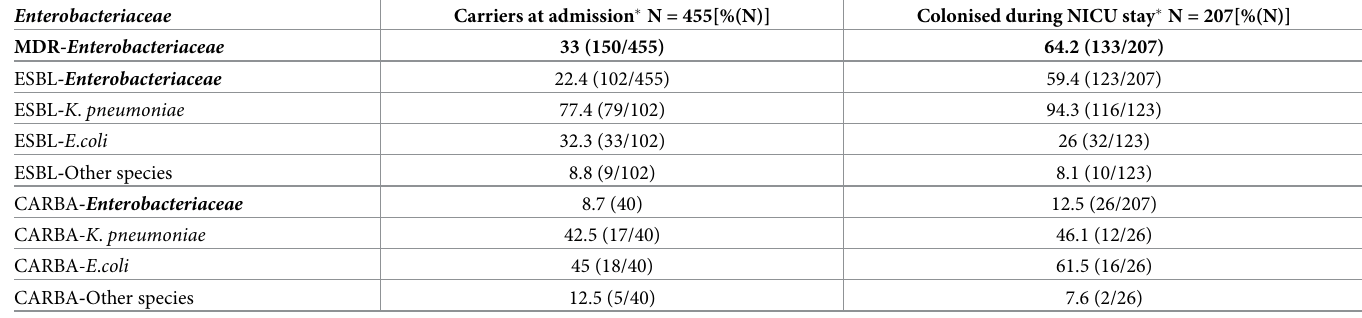
Table 1. Prevalence of ESBL and CARBA carriage among newborns hospitalised in